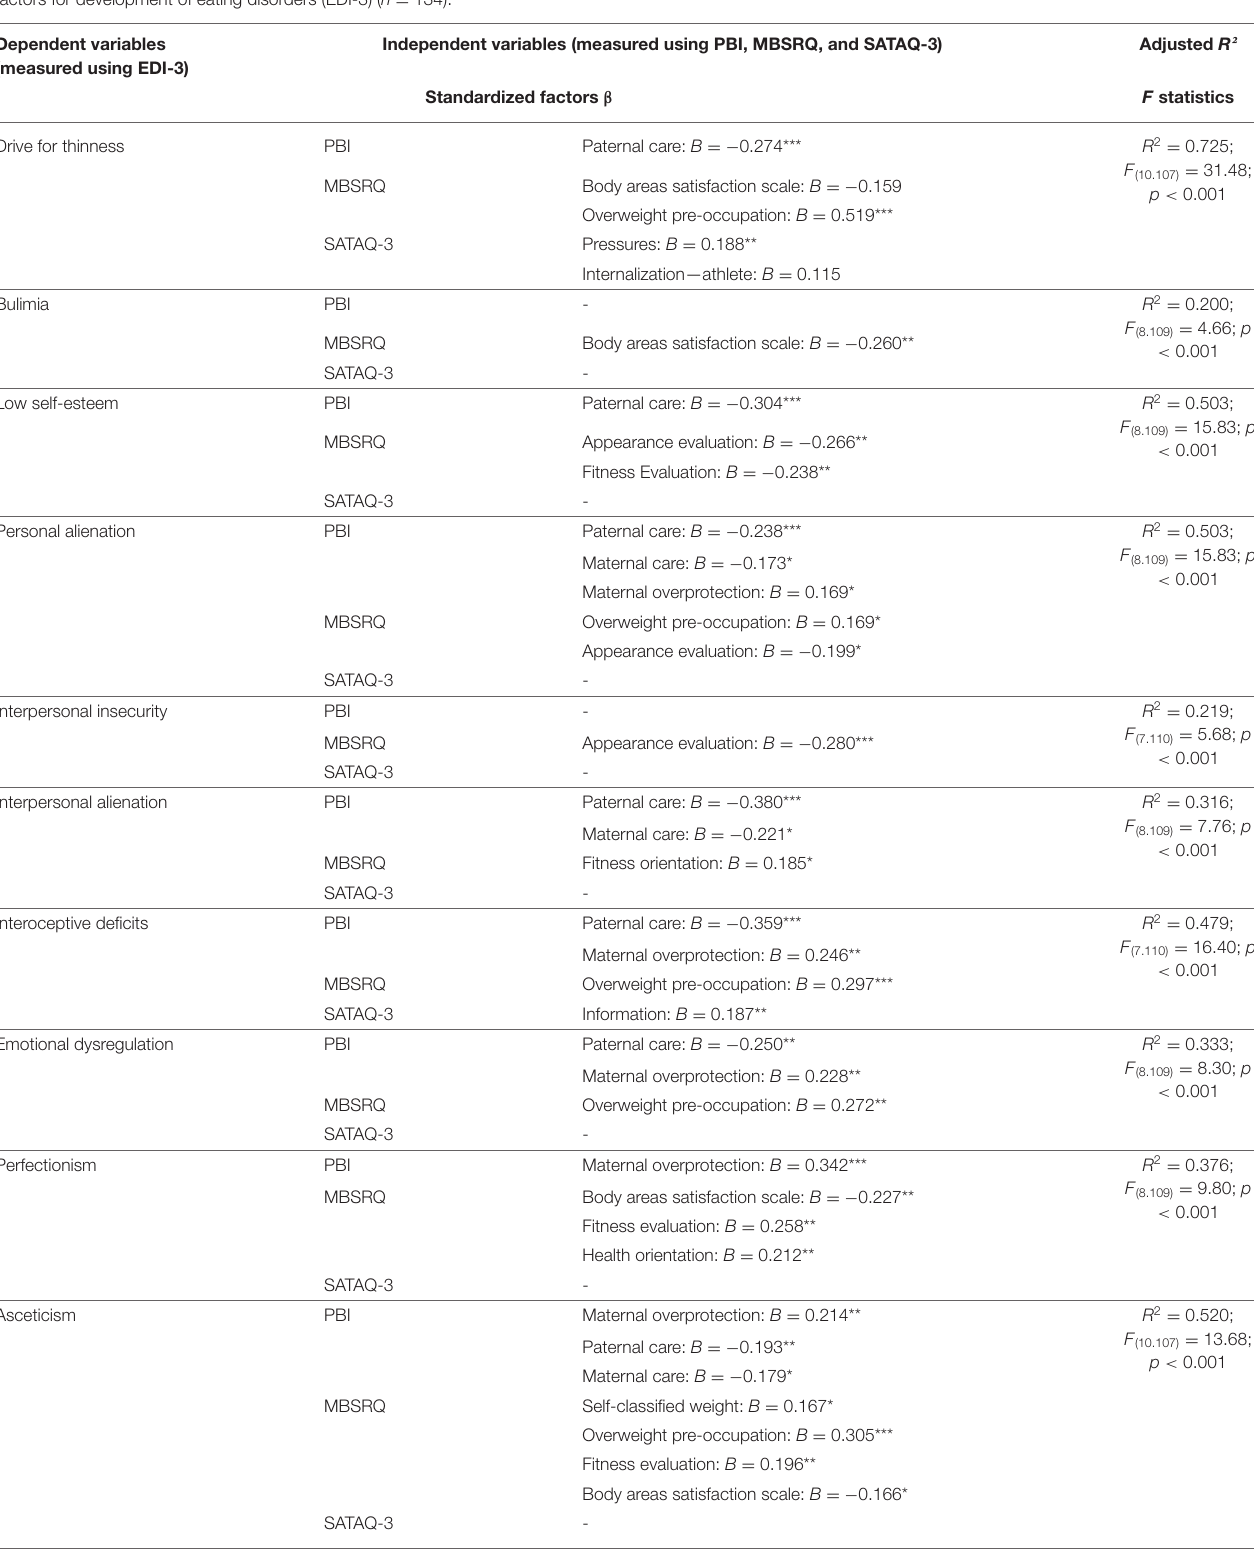
TABLE 3 | Bonding with parents (PBI), body image (MBSRQ), and sociocultural attitudes toward appearance (SATAQ-3) as predictors of protective measures and risk factors for development of eating disorders (EDI-3) ( n = 134). Dependent variables (measured using